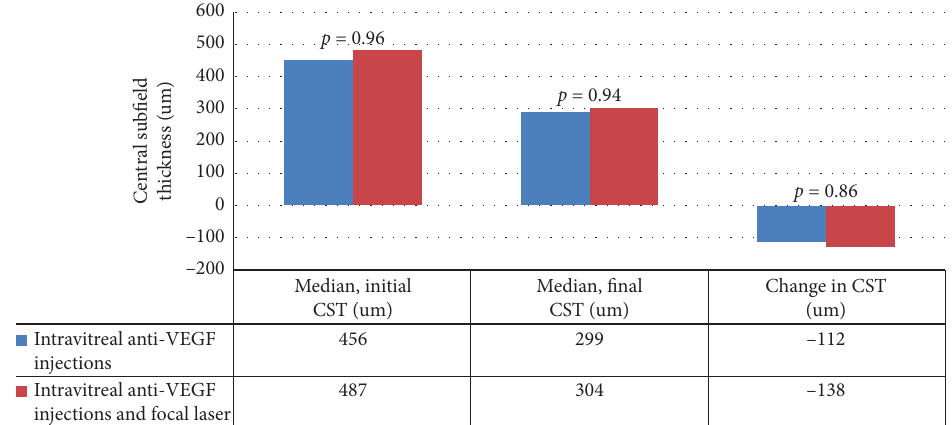
Figure 2: Central subfield thickness on OCT comparison between anti-VEGF injections alone and anti-VEGF injections combined with focal laser.